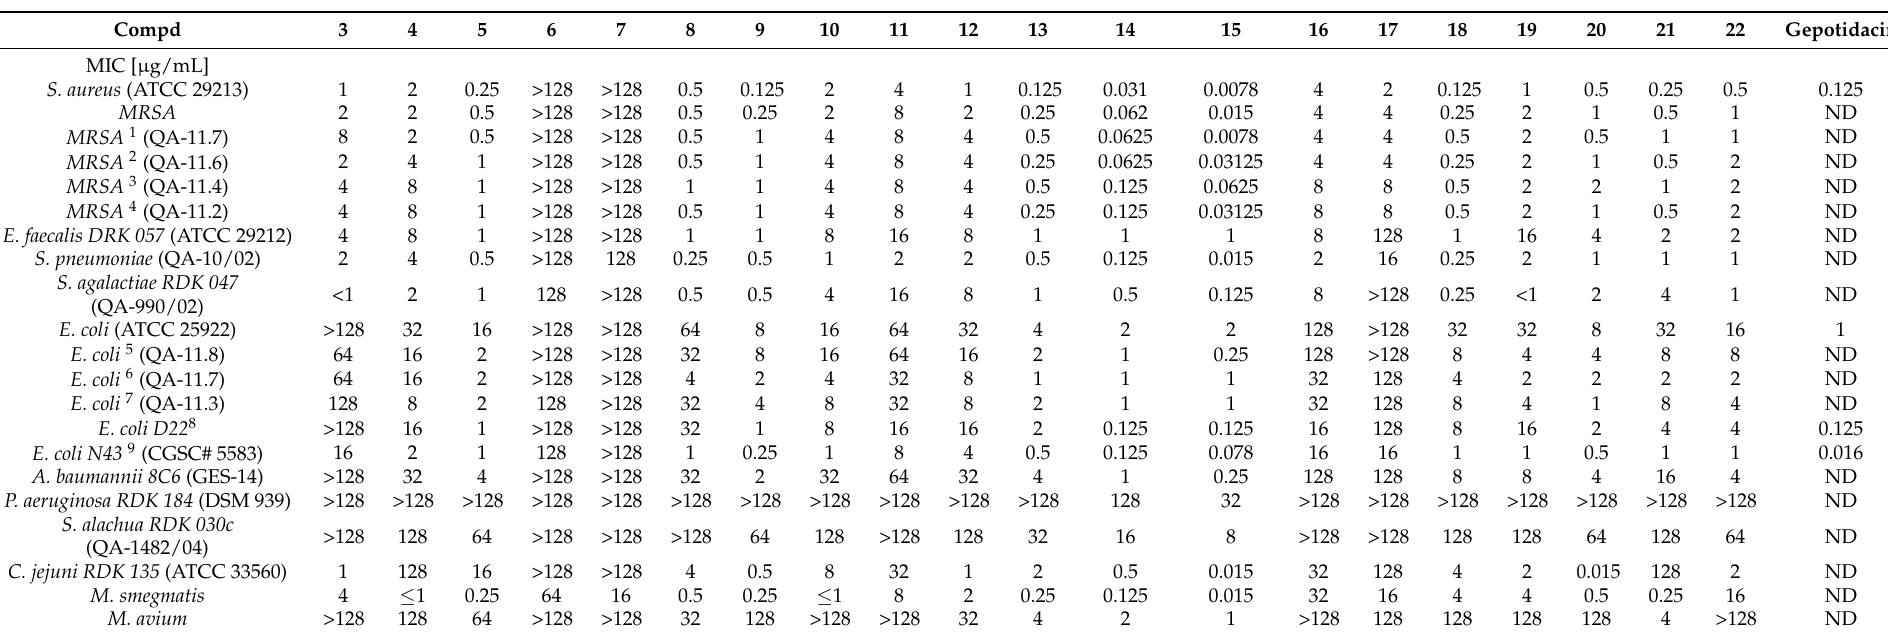
Table 2. Antimicrobial susceptibility of NBTIs against a panel of Gram-positive, Gram-negative, and Mycobacterium bacterial